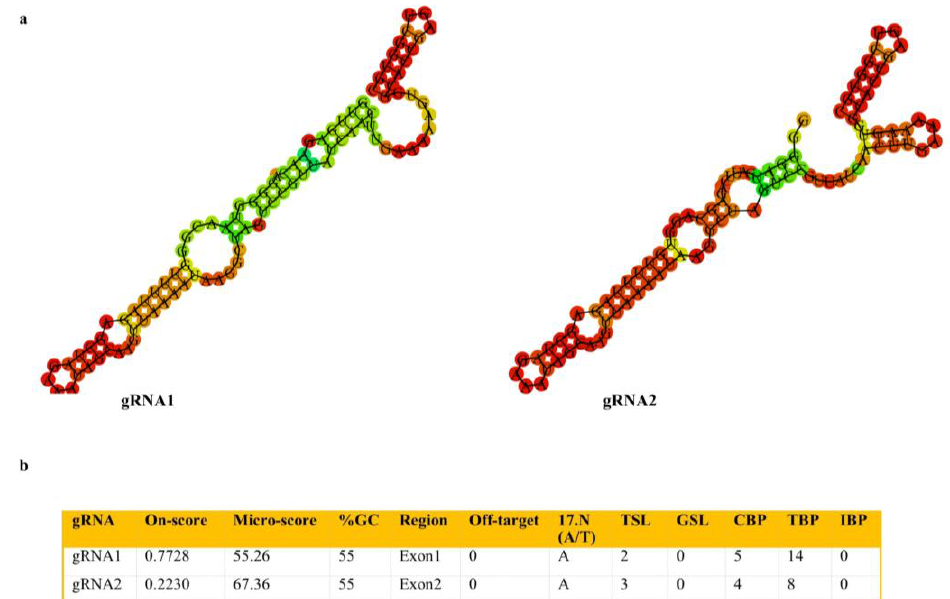
Figure 8. Some features and selection criteria of designed gRNAs targeting SlACO2 . ( a ) Minimum free energy structures of gRNAs and scaffold estimated by RNA Fold Server. ( b ) Properties of designed gRNAs provided by Crispr-P-V2.0.